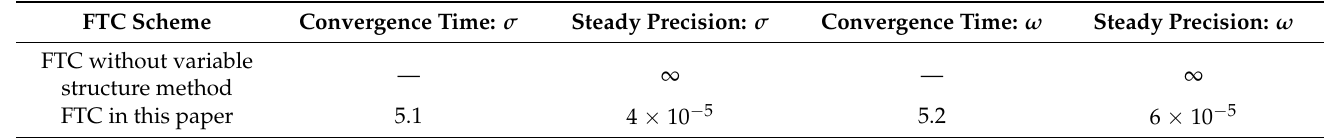
Table 4. Comparative analysis of performance with proposed FTC without variable structure har- monic